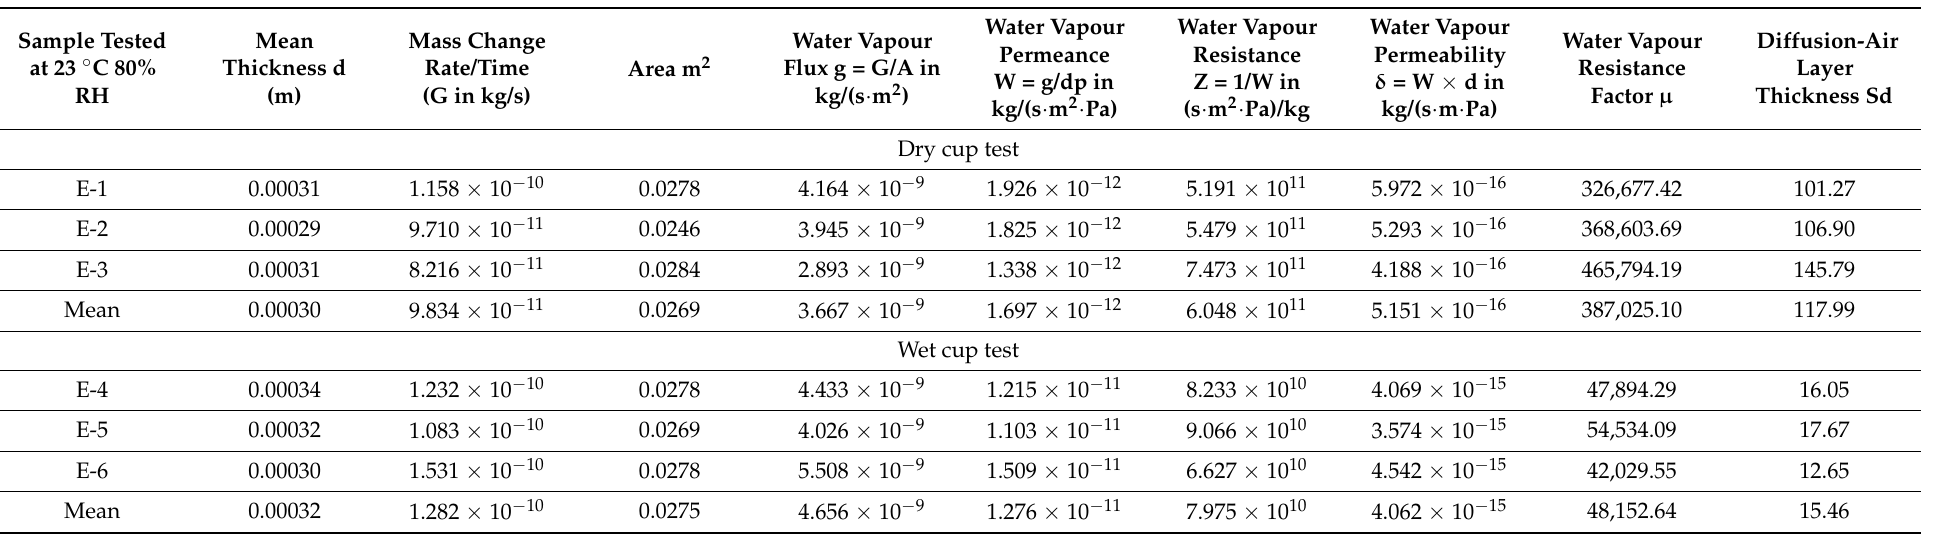
Table A13. Water vapour resistivity properties for sample E at 23 ◦ C 80%